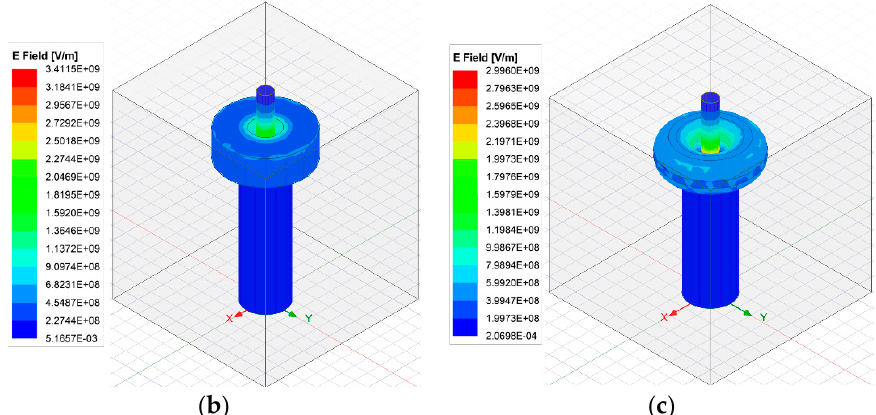
Figure 8. Single-cavity electric field model of (a) water-pipe-type coaxial resonant (b) standard- disc coaxial resonant (c) donut capacitor-loaded coaxial resonant.